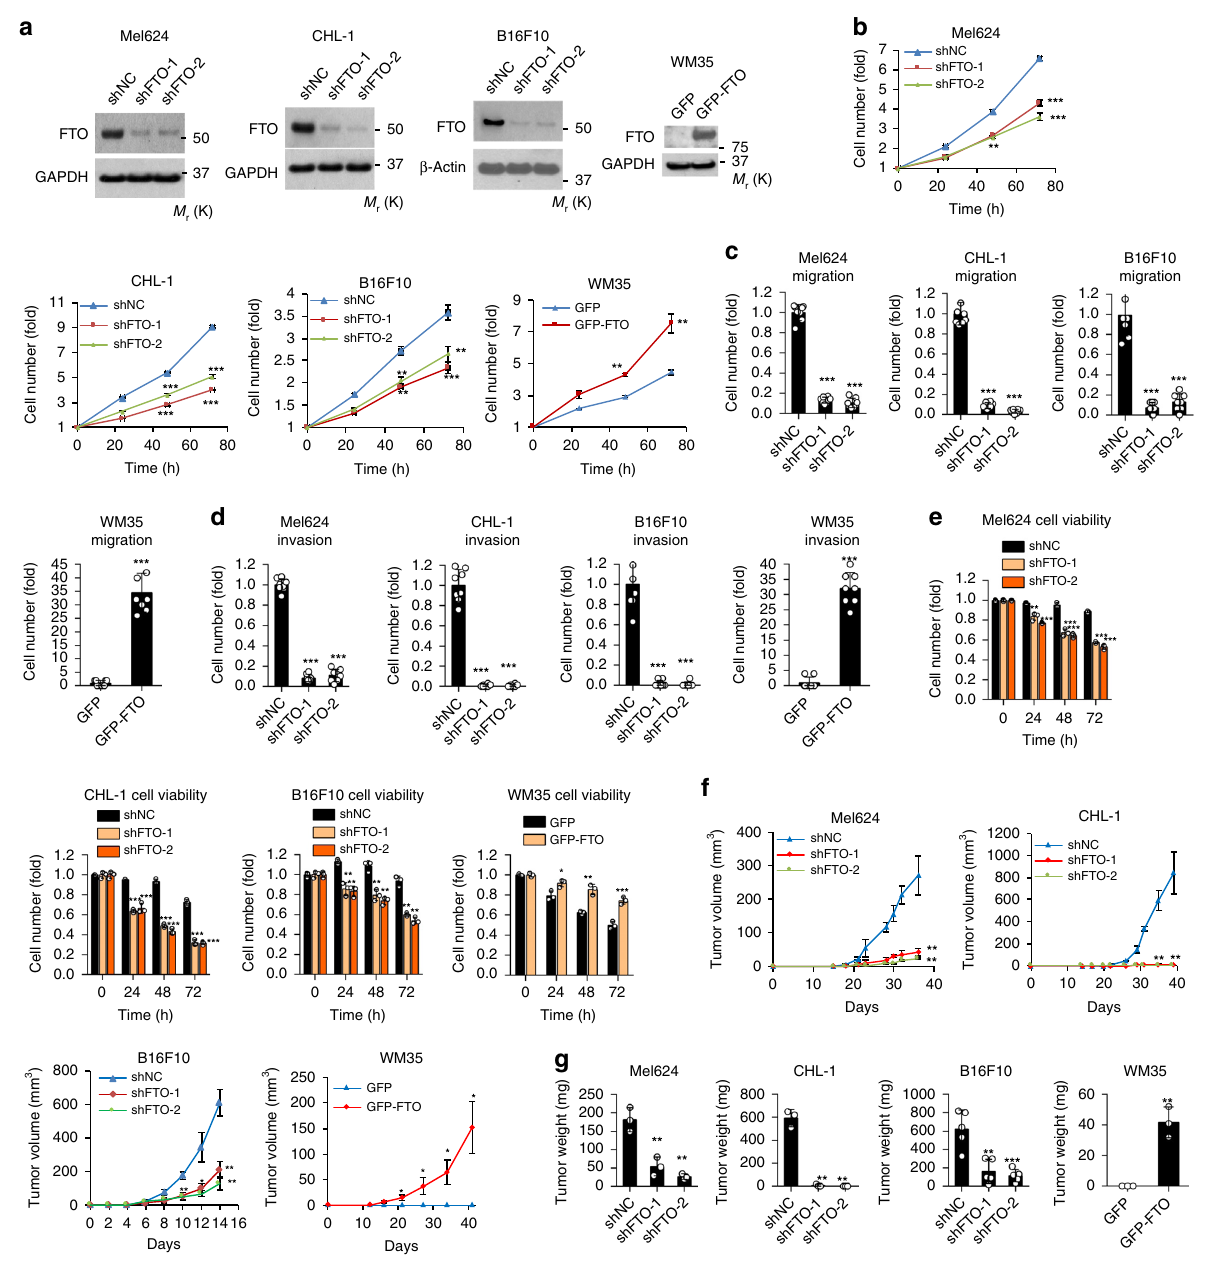
Fig. 2 Effect of FTO knockdown or forced FTO expression in melanoma cells. a Con fi rmation of knockdown or forced expression of FTO in Mel624, CHL-1, B16F10, and WM35 by immunoblot analysis. b Cell proliferation assay in Mel624, CHL-1, B16F10, and WM35 with shNC (negative control), shFTO (FTO knockdown), GFP (vector control), or GFP-FTO (FTO overexpression). c Cell migration assay with cells as in b . d Cell invasion assay with cells as in b . e Cell viability assay in cells as in b but placed in suspension. f Average tumor volume (mm 3 ) of Mel624, CHL-1, B16F10, and WM cells as in b at different days after subcutaneous injection in nude mice or C57BL/6 mice ( n = 3). g Final tumor weight from F ( n = 3). Data are shown as mean ± S.D. ( n ≥ 3). * P < 0.05; ** P < 0.01; *** P < 0.001; Student ’ s t